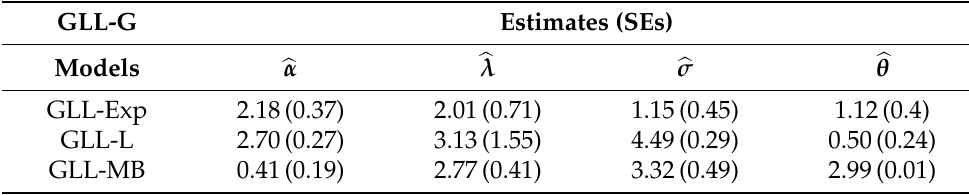
Table 3. Estimates (their standard error) of GLL-G parameters for the repairable data.